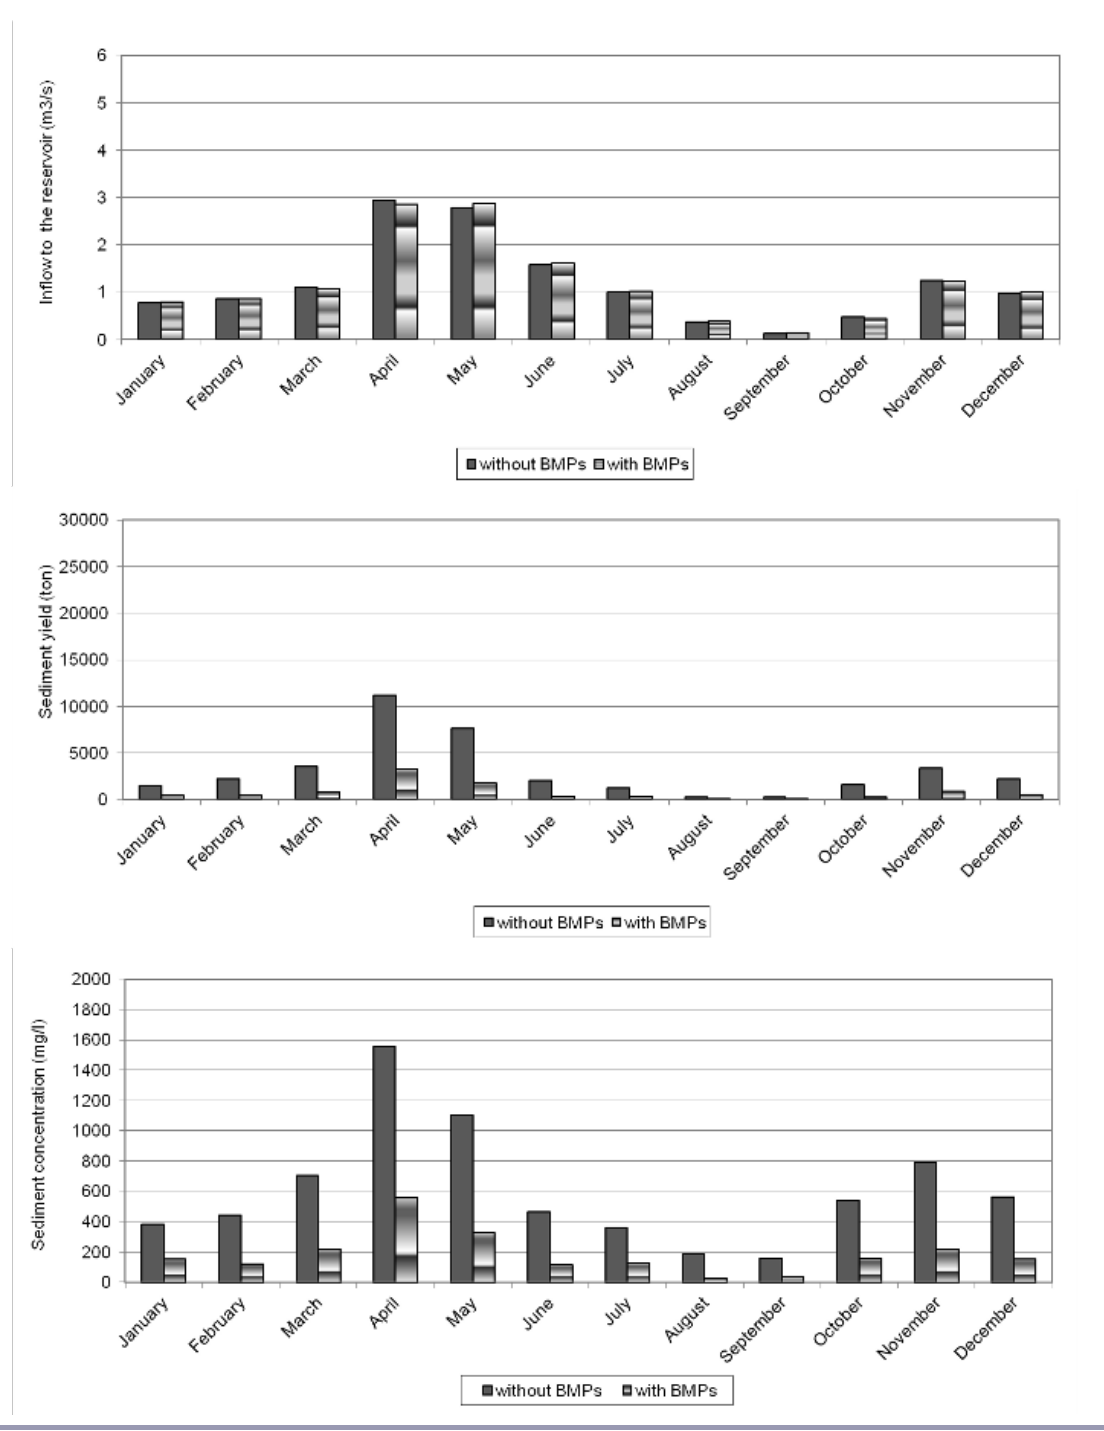
Fig. 3 . Differences in water inflow (above), sediment yield (middle), and sediment concentration (below) with and without best management practices (BMPs) for Scenario